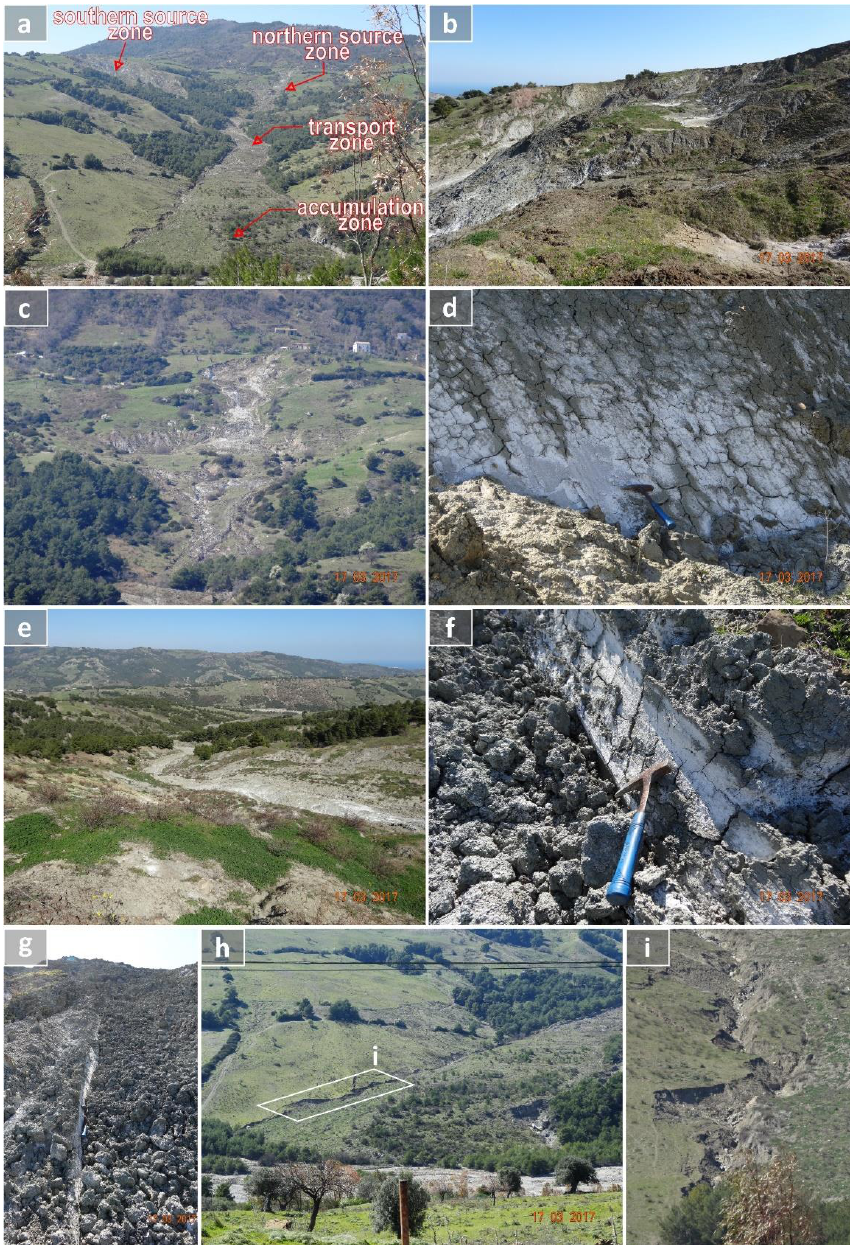
Figure 5. Landslide features observed in the study catchment: ( a ) panoramic view of the Vomice earthflow; ( b , c ) respectively southern and northern source areas where a series of rotational or compound slides occur; ( d ) detail of an active main scarp (in the southern source zone) overprinted by evident striae; ( e ) transport zone of the landslide; ( f , g ) well-preserved striated shear planes along the edges of the earthflow in the transport zone; ( h ) deposition zone of the landslide, and ( i ) deep erosive channels, along the right and left side of the flow.